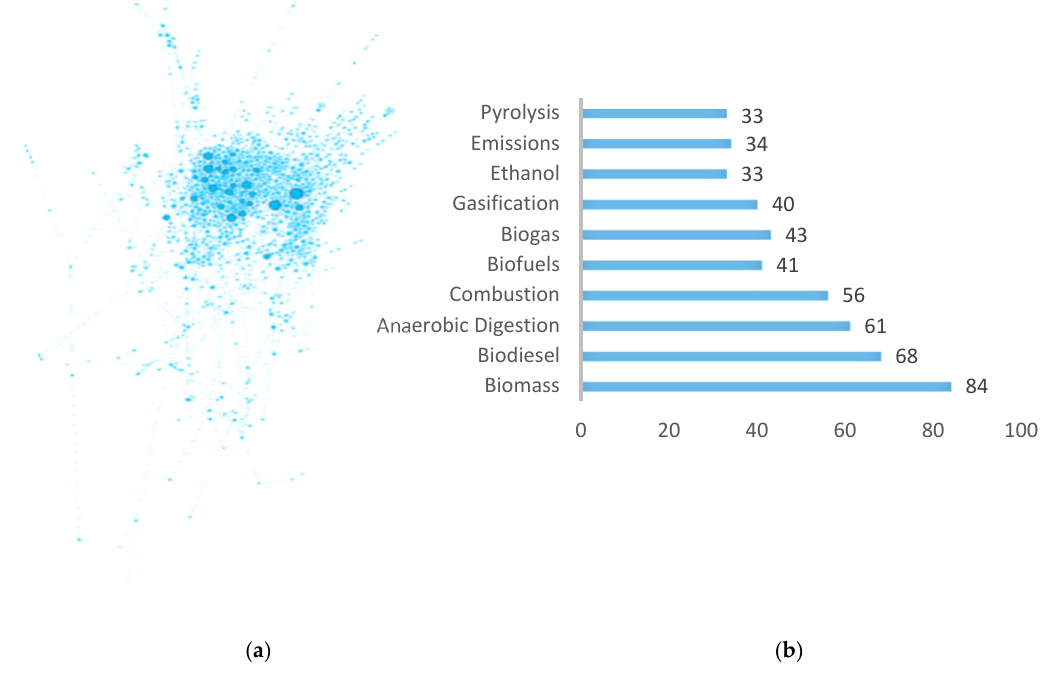
Figure 15. Bioenergy sources: ( a ) manuscripts published, ( b ) keywords.